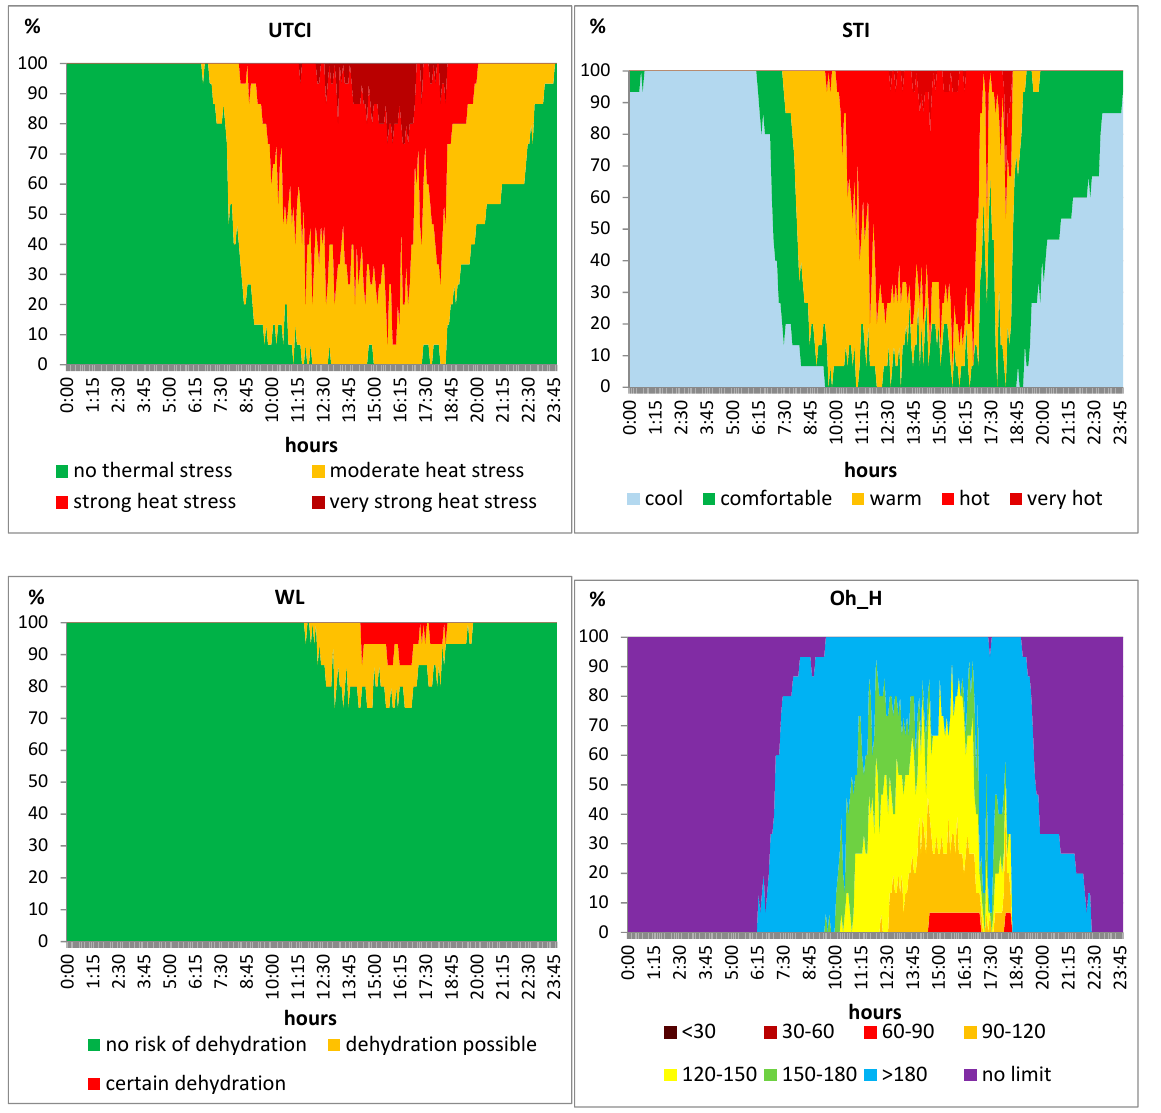
Figure 7. Diurnal heat stress (UTCI), subjective temperature (STI), water loss (WL), and overheating risk (Oh_H) during subsequent hours in Bydgoszcz on hot days in June 2019.